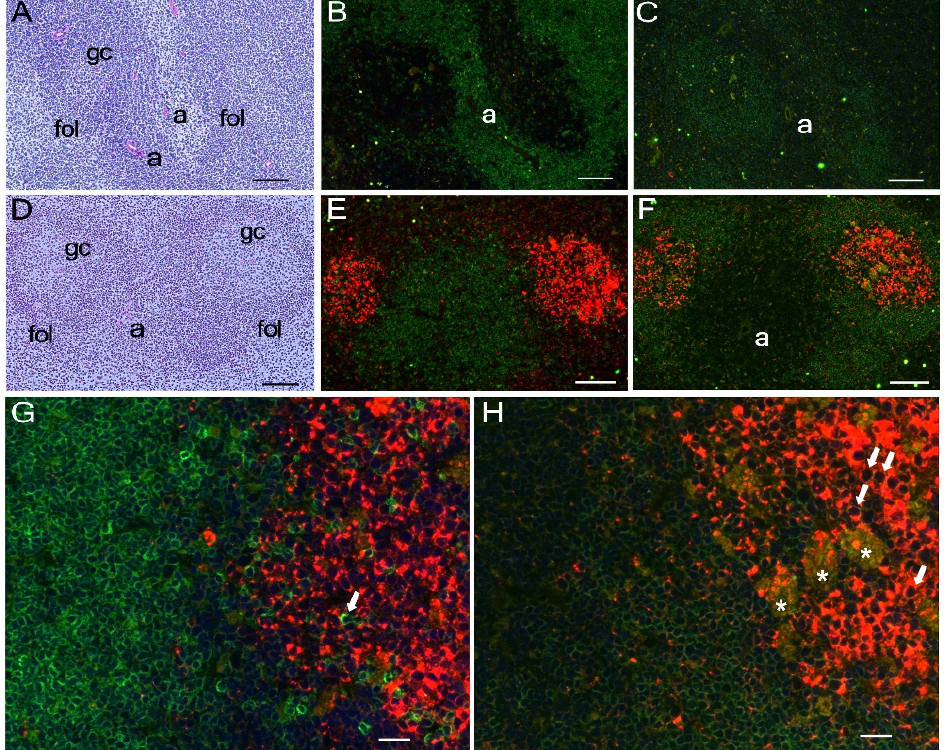
Figure 3. Immunohistochemical detection of FLAG-tagged mA3 protein in the spleen. Frozen tissue sections prepared from WT B6 ( A – C ) and homozygous FLAG-KI mice ( D – H ) were stained with hematoxylin and eosin (HE, panels ( A , D )), fluorescent Ab specific for CD3 (green) and FLAG (red) (panels ( B , E , G )) or with Ab specific for B220 (green) and FLAG (red) (panels ( C , F , H )). Panels ( A – C ) and ( D – F ) respectively show corresponding view fields from serial sections. Bars indicate 100 µ m in panels ( A – F ), and 20 µ m in ( G , H ). In panels ( A – F ), “a” indicates a central artery, “fol” a follicle, and “gc” a germinal center within a follicle in the white pulp. Note that CD3 + T cells are located surrounding the central artery and B220 + cells are accumulated in follicles as expected. In panels ( F , H ) cells in GC show an orange color, while those in panels ( E , G ) are stained red, indicating that GC cells are positive for both B220 and FLAG. Higher magnification shows the presence of T cells within GC that are negative for FLAG (arrow in panel ( G )), and cytoplasmic location of FLAG-tagged mA3 in GC B cells sparing nuclei (arrows in panel ( H )). Apparent tingible body macrophages are indicated with asterisks. Immunohistochemical staining was performed a total of 7 times with a few specimens for each genetic group in each experiment with results essentially identical to those shown